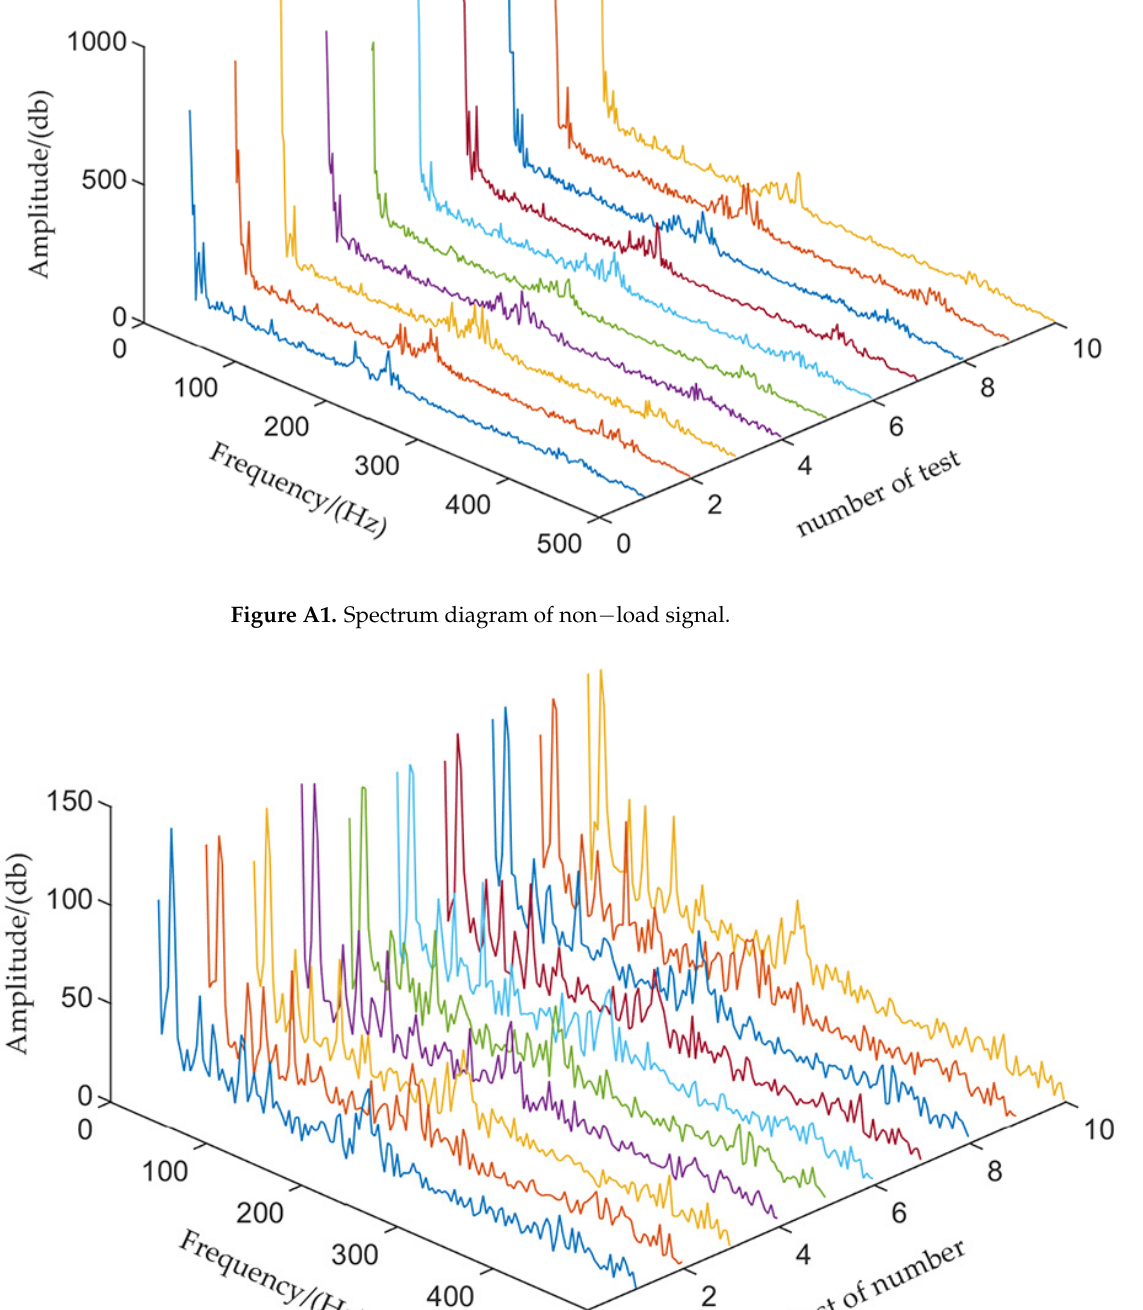
Figure A3. Decomposition result of the EMD method.